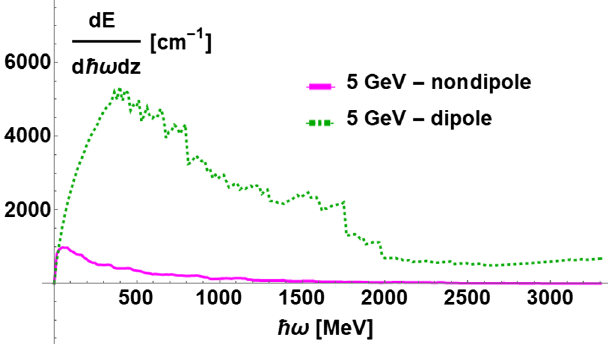
6. Comparison of CR spectra calculated in the dipole and nondipole approximation for electrons of energy 5 GeV axially channeled along the h 100 i axis of a 20 - μ m-thick W single crystal at parallel incidence with respect to the crystal